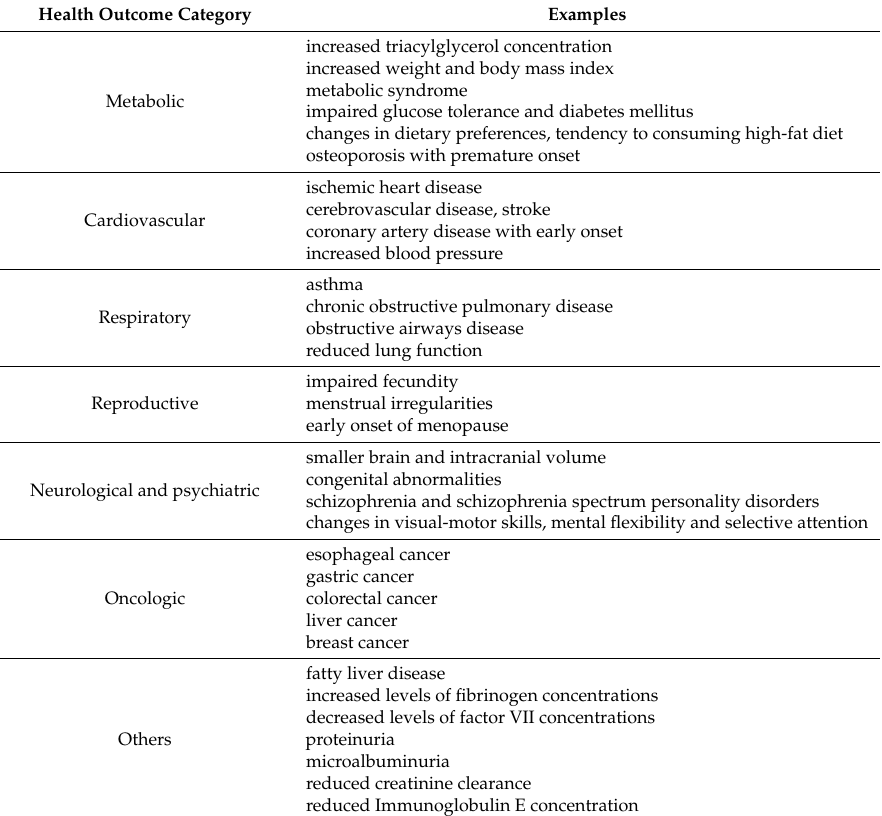
Table 2. The health outcomes of famine exposure by the affected